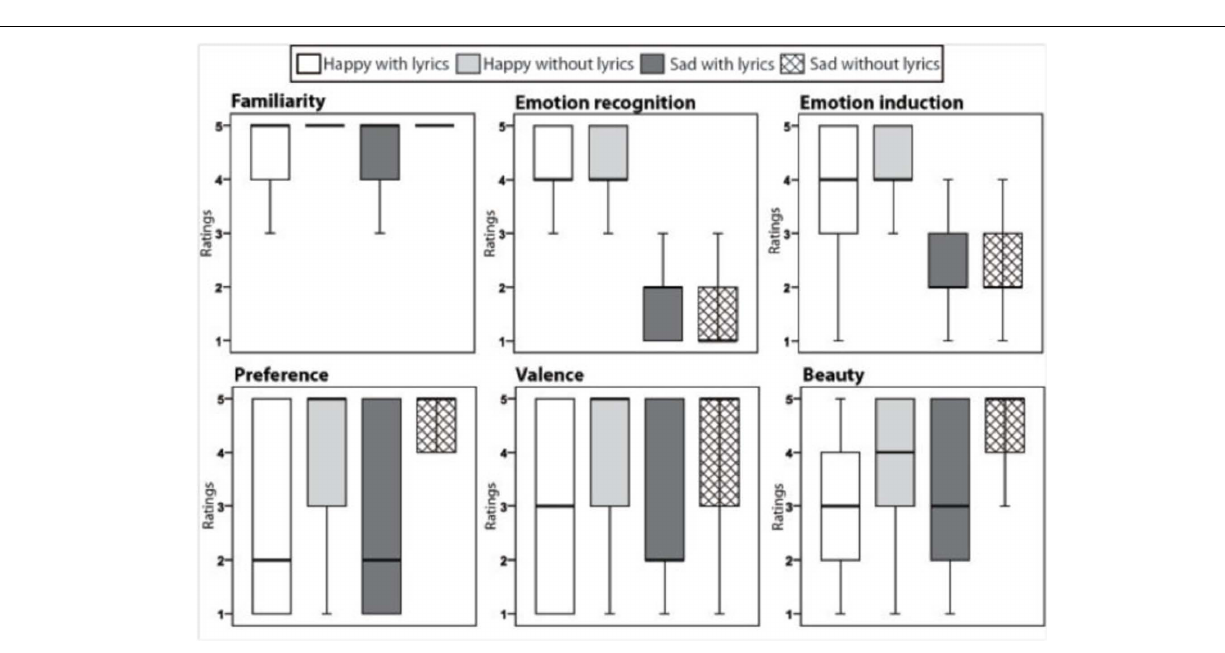
Frontiers in Psychology | Auditory Cognitive